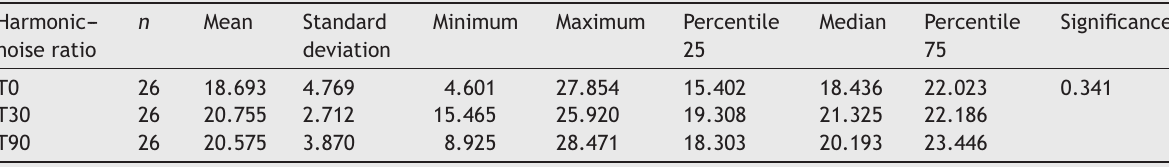
Harmonic---noise ratio --- Vowel /i/. Harmonic---